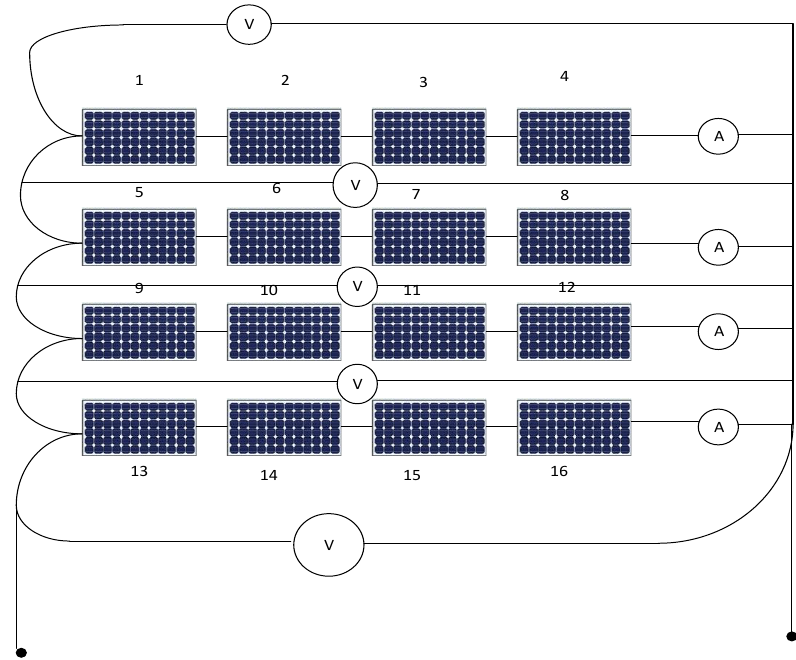
Figure 1. Photovoltaic array arrangement.